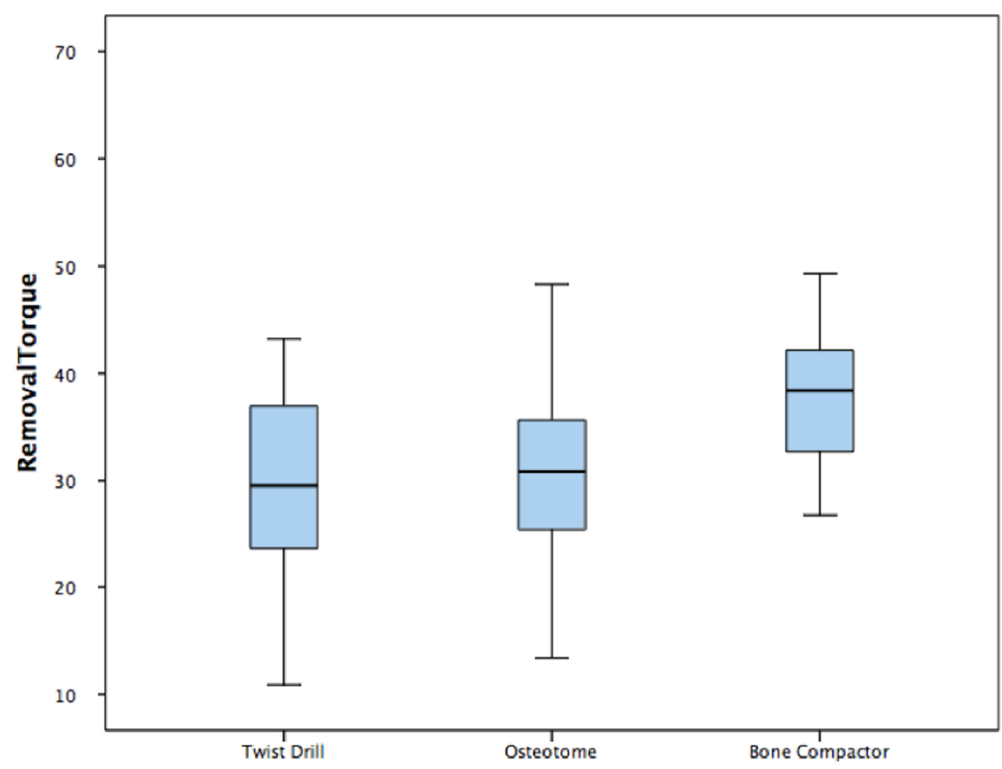
Figure 8. Box plot—Removal torque.